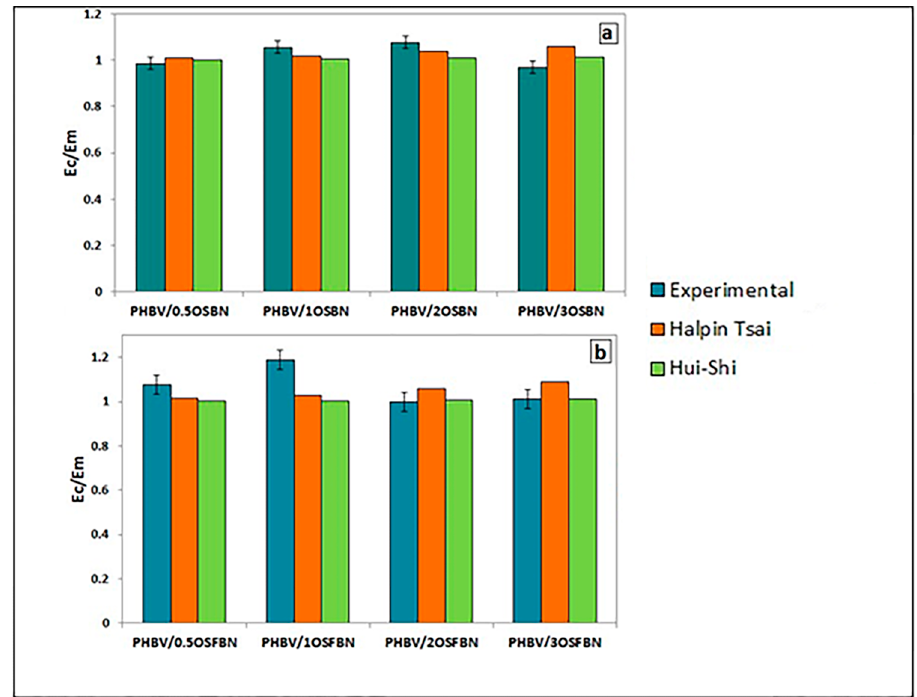
Figure 12. Comparison of mechanical models with experimental data for ( a ) PHBV/OSBN and ( b ) PHBV/OSFBN nanocomposites. Table 6. Deviation (%) in E c /E m of nanocomposites for mechanical models.